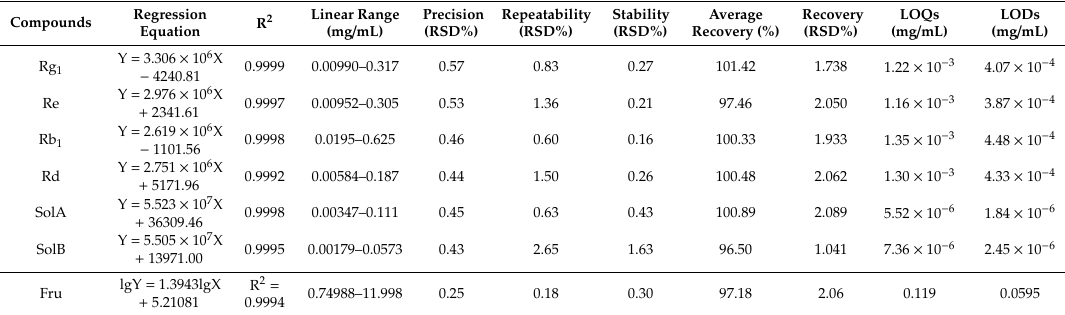
Table 1. Regression equation, R 2 , linear range (mg / mL), precision, repeatability, stability, recovery for 7 compounds.